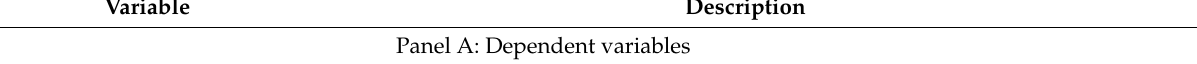
Table A2. Major Variables Used in the